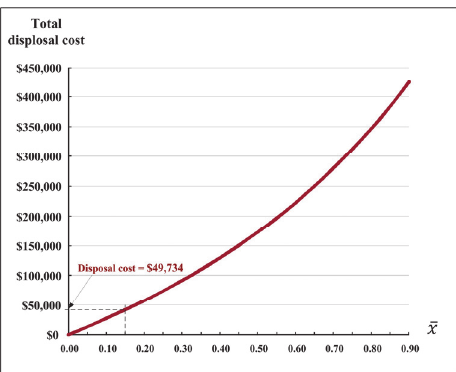
Fig. 3. Effect of changes in average random scrap rate x on total disposal cost